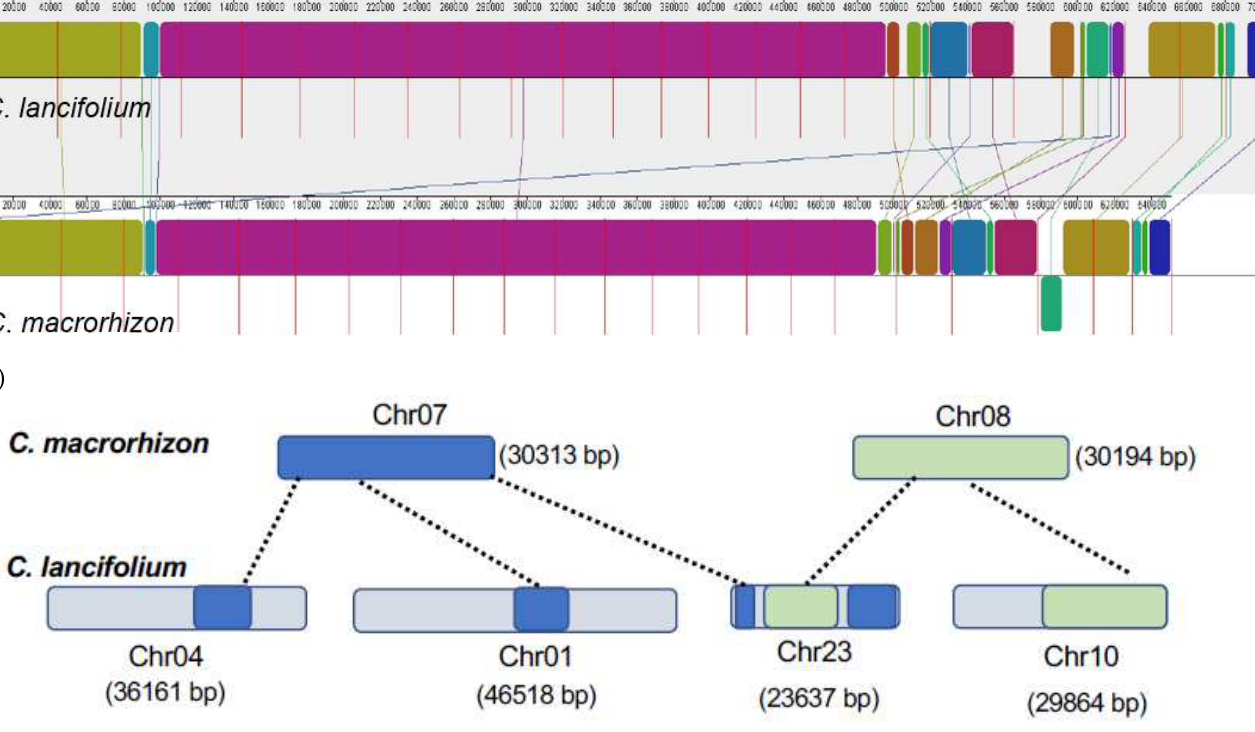
Figure 3. The maintenance and turnover of synteny between the C. lancifolium and C. macrorhizon mitogenomes. ( A ) The overall whole-genome synteny between the two mitogenomes. Syntenic blocks were identified by using progressiveMauve implemented in Mauve. Upper: C. lancifolium ; lower: C. macrorhizon. ( B ) Inter-chromosomal synteny relationship between the C. lancifolium and C. macrorhizon mitogenomes.